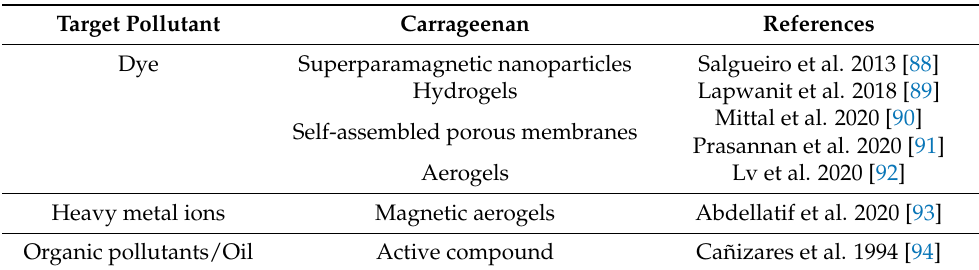
Table 4. Carrageenans’ potential for pollutants’